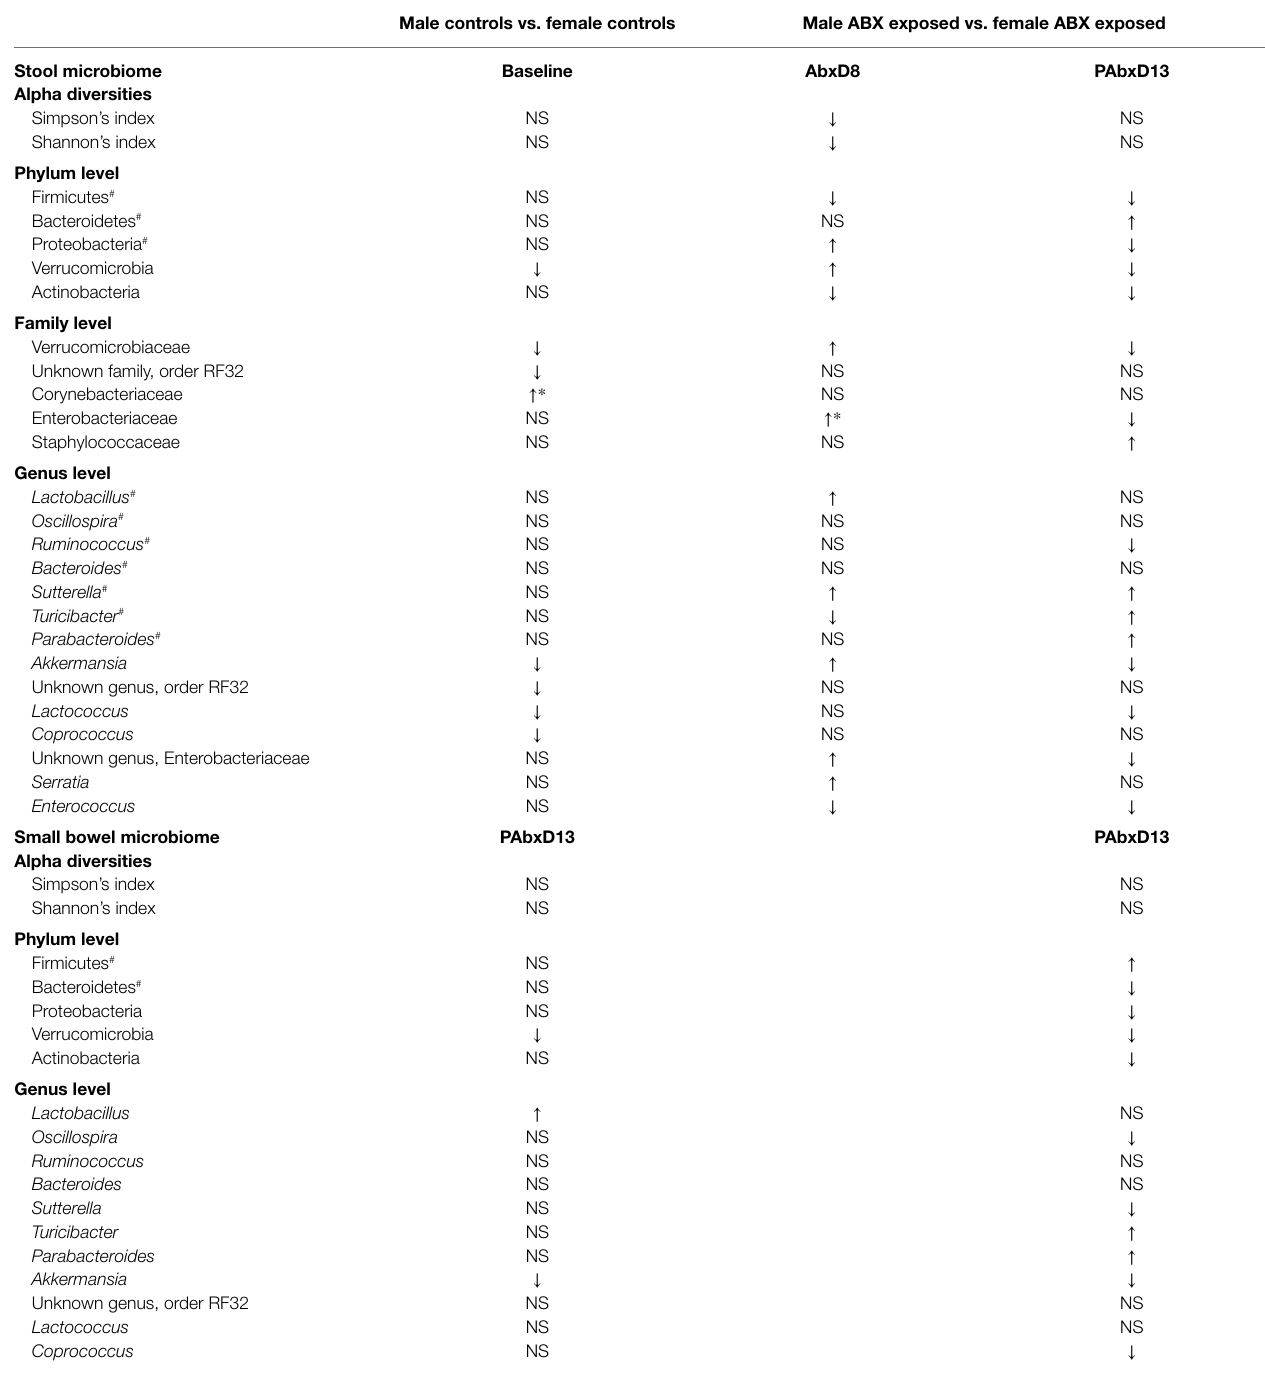
TABLE 1 | Overview of the most significant changes in taxa seen post antibiotic exposure in males compared to females at the phylum, family, and genus levels in both the stool and small bowel microbiomes. Male controls vs. female